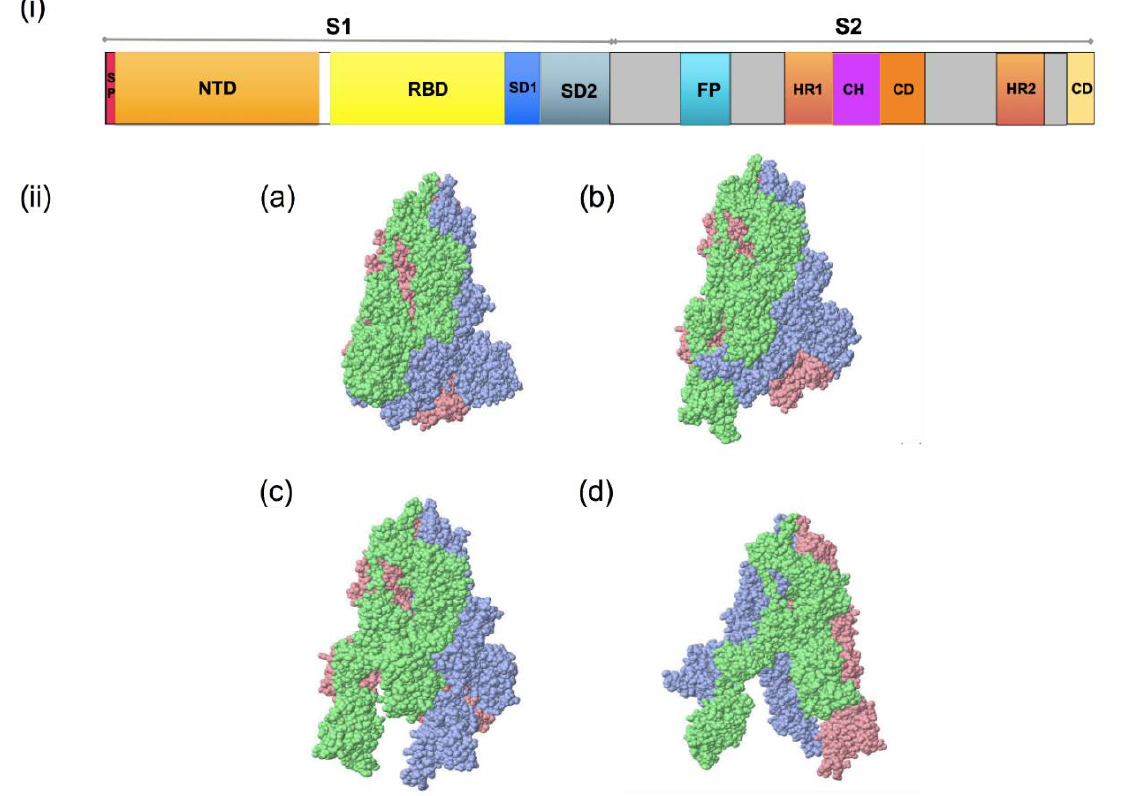
Figure 3. Spike glycoprotein of SARS-CoV-2; ( i ): S1/S2 protease cleavage site; SP: signal peptide; NTD: N-terminal domain; RBD: receptor-binding domain; RBM: receptor-binding motif; FP: fusion peptide; HR1: heptapeptide domain 1; HP2: heptapeptide domain 2; TM: transmembrane domain; CD: cytoplasmic domain 3. ( ii ): SARS-CoV-2 spike glycoprotein trimeric structure showing chains A (pink), B (blue) and C (green) of ( a ) closed state (7DF3), ( b ) 1 RBD up (7LWT), ( c ) 2 RBD up (7LYK) and ( d ) 3 RBD up (7CAK) (figure visualized using USF Chimera).